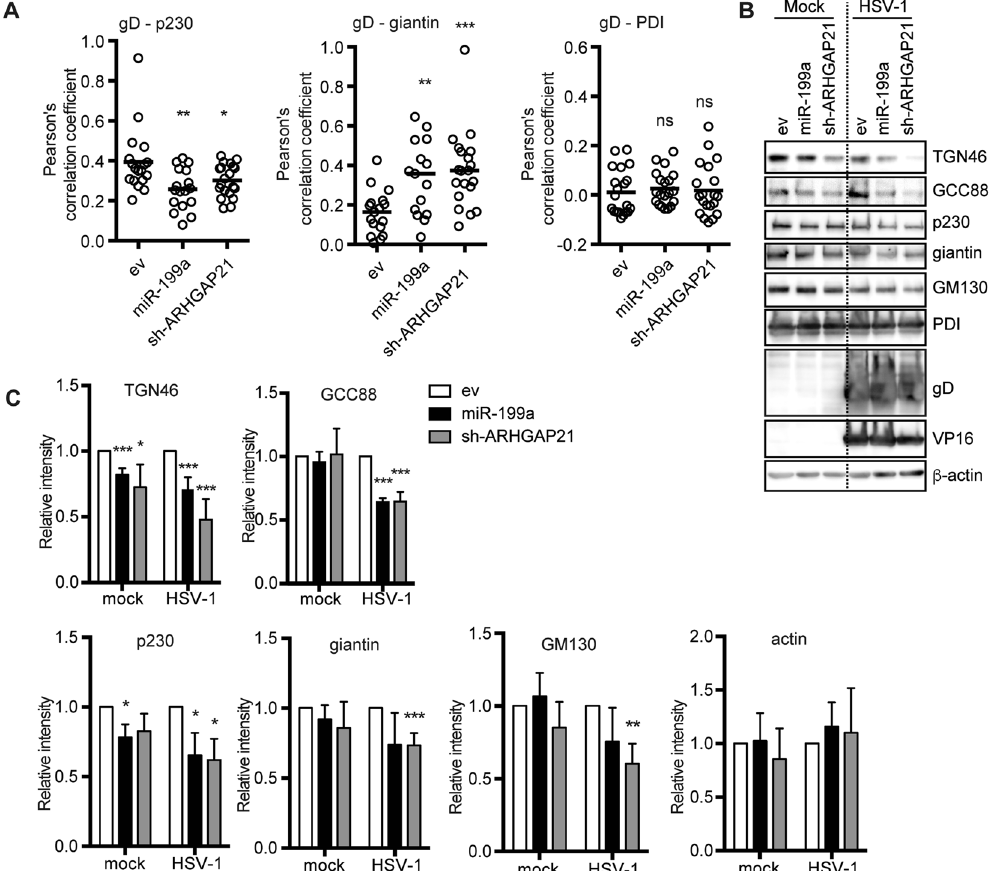
Figure 7. ARHGAP21 is required for maintenance of the trans -Golgi during HSV-1 infection. ( A ) To quantify the colocalization of gD with the organelle markers p230 ( trans -Golgi), giantin (medial- and cis -Golgi), and PDI (ER), the Pearson’s correlation coefficient was determined for confocal images of HSV-1-infected A549 cells (moi of 5/12 hpi) transfected with control (ev), pre-miR-199a-, or sh-ARHGAP21#01-expressing lentivirus vector. ( B , C ) Western blot analysis of TGN (TGN46), trans -Golgi (GCC88 and p230), medial- or cis -Golgi (giantin and GM130), and ER (PDI) markers, HSV-1 proteins (gD and VP16), and β -actin in uninfected or HSV-1-infected (moi of 5/20 hpi) A549 cells transfected with control (ev), miR-199a-, or sh-ARHGAP21#01- expressing lentivirus vector. Protein levels of these Golgi markers were quantitated by measuring band intensities of western blot images using Image J software. In B, the bars represent the medians and the asterisks indicate the p value ( t -test) compared with control (ev). ns, not significant. * p < 0.05, ** p < 0.01, *** p <